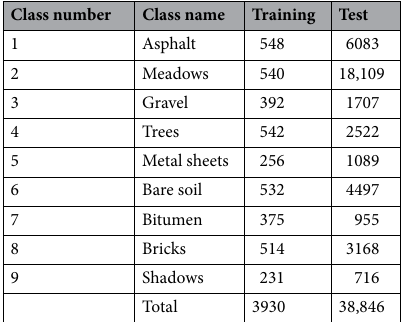
Table 2. Number of training and testing samples in the Pavia University Dataset.